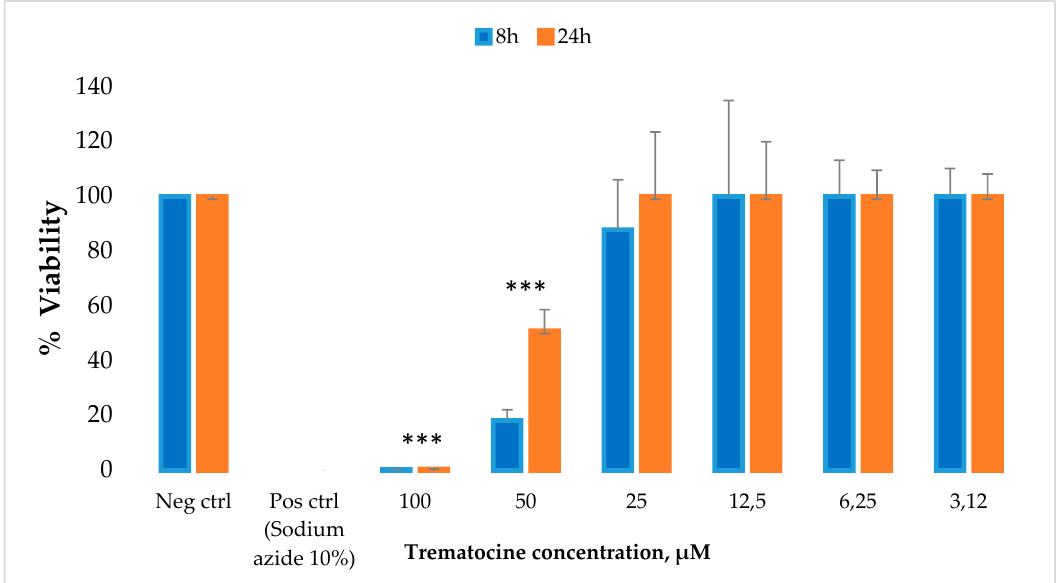
Figure 11. Cytotoxic activity of Trematocine against a primary human fibroblast cell line (FB789). Six different concentrations have been tested. The values represent the mean + SD, and the asterisks indicate the significance level with respect to negative control (100% of viability). *** = p < 0.001 .